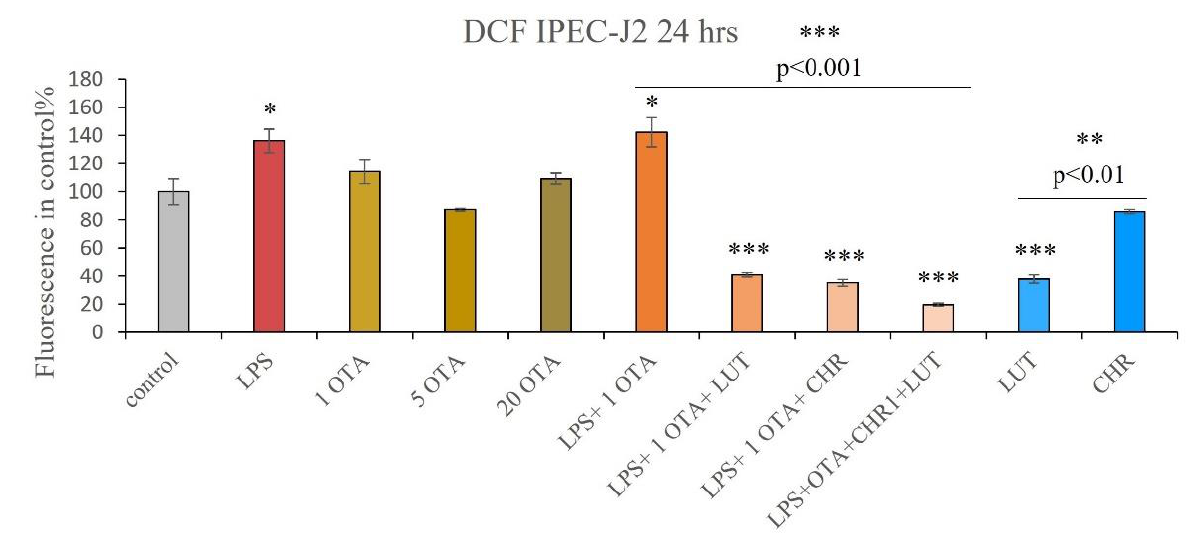
Figure 5. Relative fluorescence intensity in control% using DCFH-DA method. Measurement of IC ROS levels after 24 hrs treatment of IPEC-J2 cells with 1 µM OTA, 5 µM OTA, 20 µM OTA, 1 µM CHR, 8.7 µM LUT, 10 µg/mL LPS and their combinations; data are shown as means of relative fluorescence intensities with SEM; n = 3 samples per group, * indicates p < 0.05, ** indicates p < 0.01, *** indicates p < 0.001; λ exc = 480 nm, λ em = 530 nm. Asterisks alone indicate significant differ- ences between control and treated groups, asterisks with p values underlined show significant changes between the designated groups.